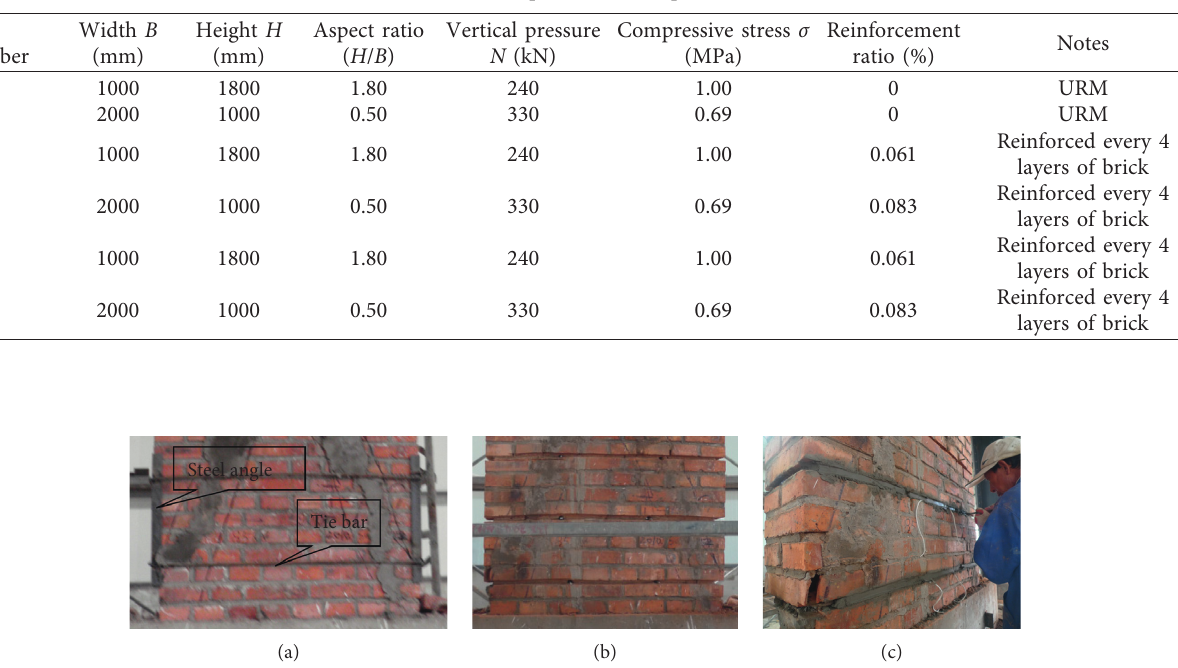
Table 3: Basic parameters of specimens.